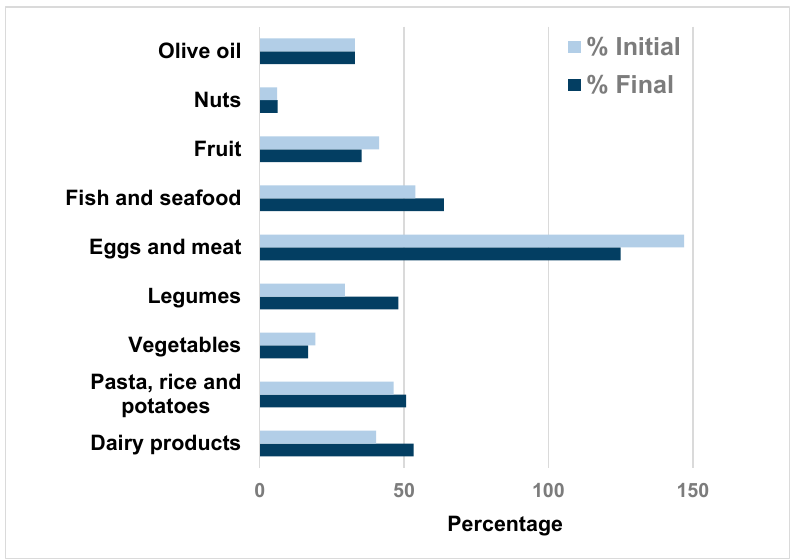
Figure 1. Intake of food groups with respect to recommendations at the beginning and end of the study. The results were expressed as the percentage of food group intake with respect to the recommendations for each group [32]. The 100% value represented the recommended intake.